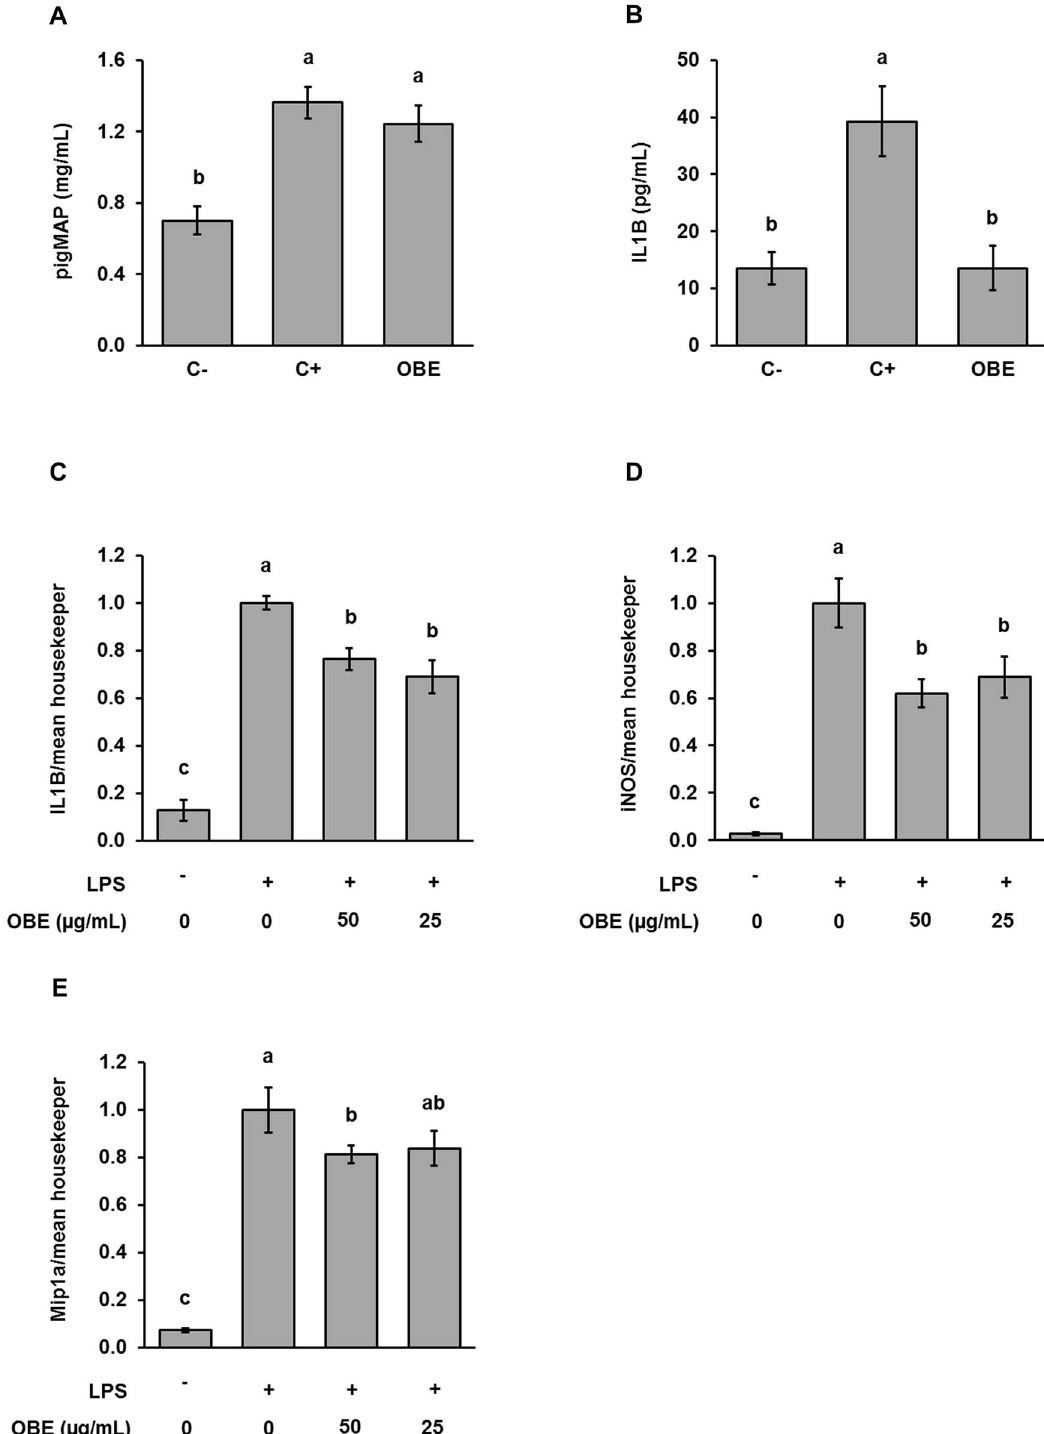
Fig 2. Immune-inflammatory response of pigs and macrophages treated with an Olive-oil Bioactive Extract (OBE) and challenged with LPS. (A, B) Concentration of pigMAP and ILB1 in peripheral circulationof pigs. Piglets were fed a commercial diet untreated(C-, C+) or supplemented with an olive-oilextract (OBE; 500 mg/kg diet). On d 20, 23, 26 and 29, OBE and positive control (C+) pigs received E . coli -derived LPS injections at increasing doses (60, 66, 72 and 78 μ g/ kg). Negative control animals(C-) were injectedwith saline. Plasma samples were collected 3 h after final LPS